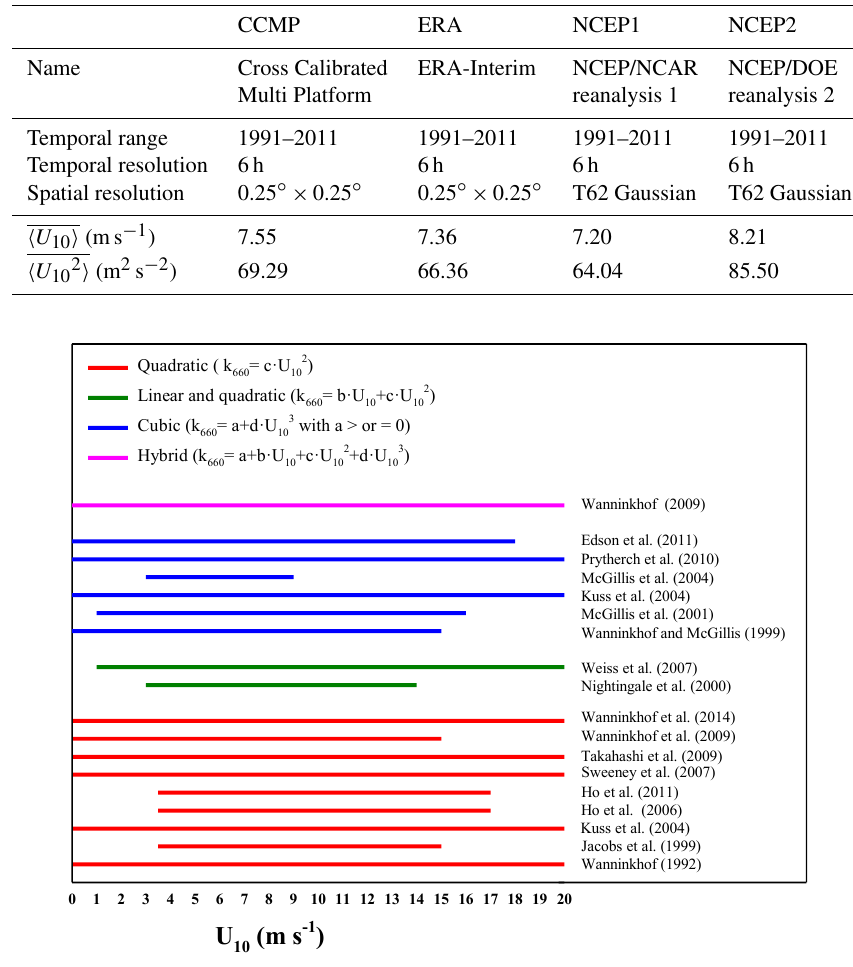
Figure 1. List of k − U 10 relationships (quadratic, cubic, linear and quadratic and hybrid) reported in the literature for the ocean with their range of